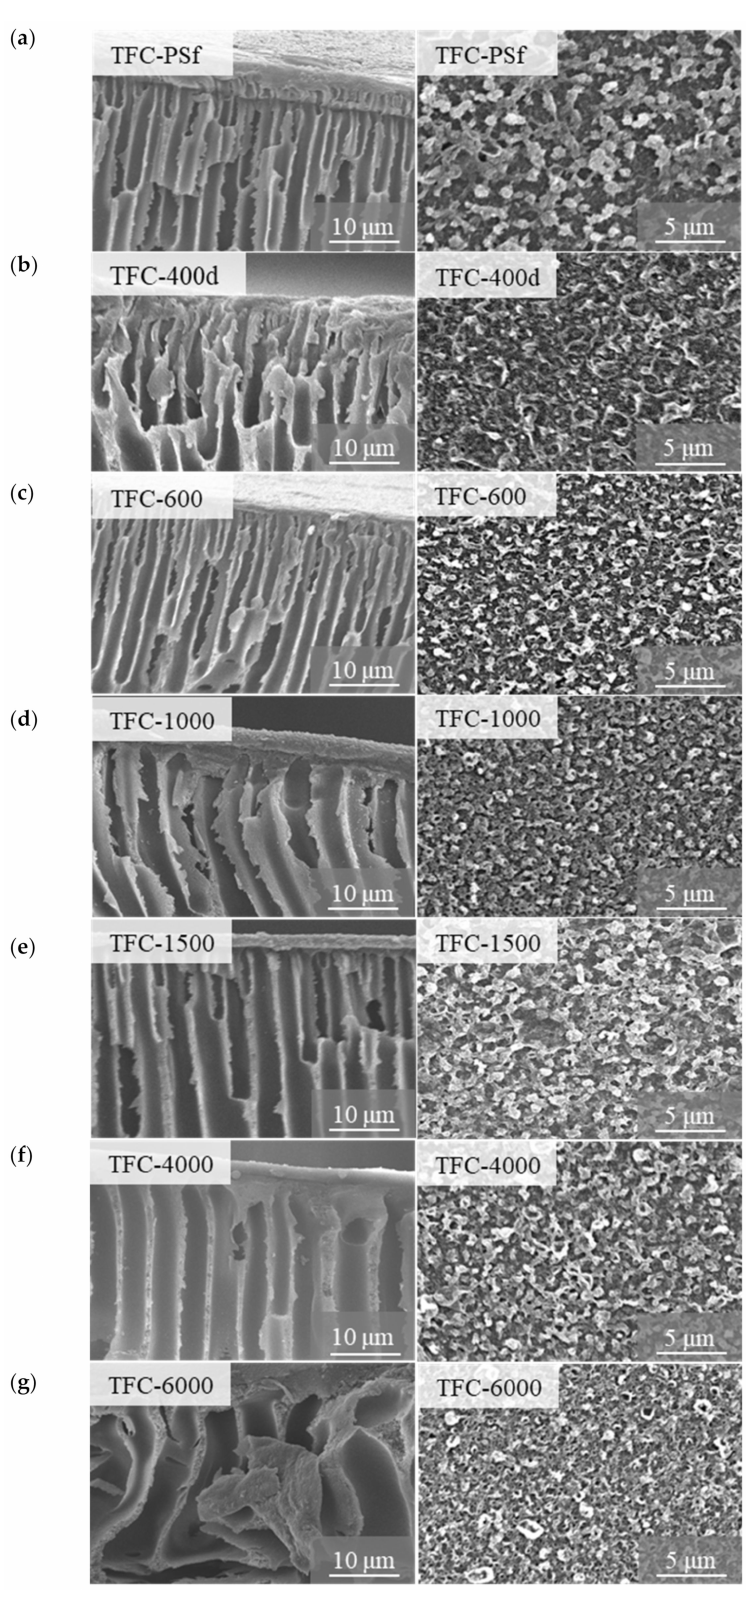
Figure 3. SEM images of the cross-sections and top surfaces of the pristine TFC membrane and modified TFC membranes: ( a ) TFC-PSf; ( b ) TFC-400d; ( c ) TFC-600; ( d ) TFC-1000; ( e ) TFC-1500; ( f ) TFC-4000; and ( g )